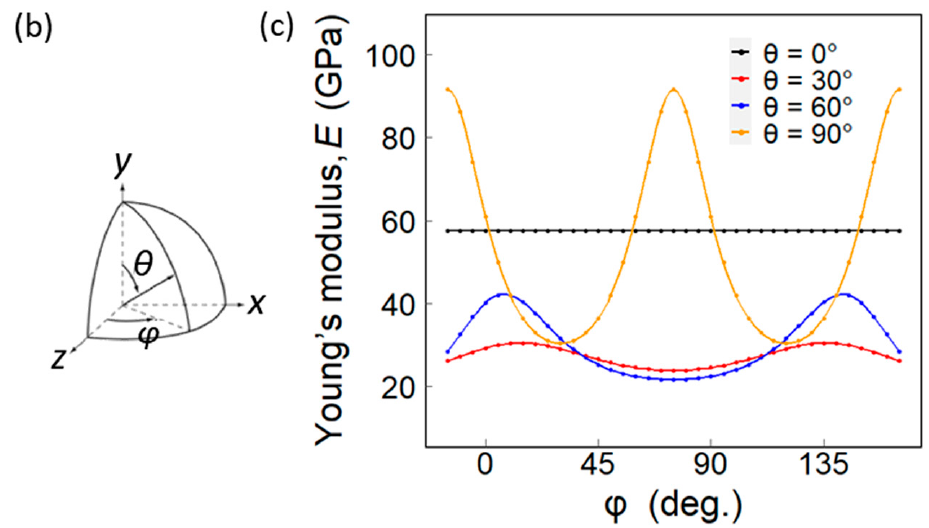
Figure 6. ( a ) A rhombohedral calcite unit cell is defined in the hexagonal coordinate. The parallelepiped represents a calcite lattice. The blue lines illustrate the hexagonal crystal system. ( b ) Schematic diagram of θ and ϕ of ( c ). ( c ) The theoretical Young’s modulus of calcite under different azimuthal angles.